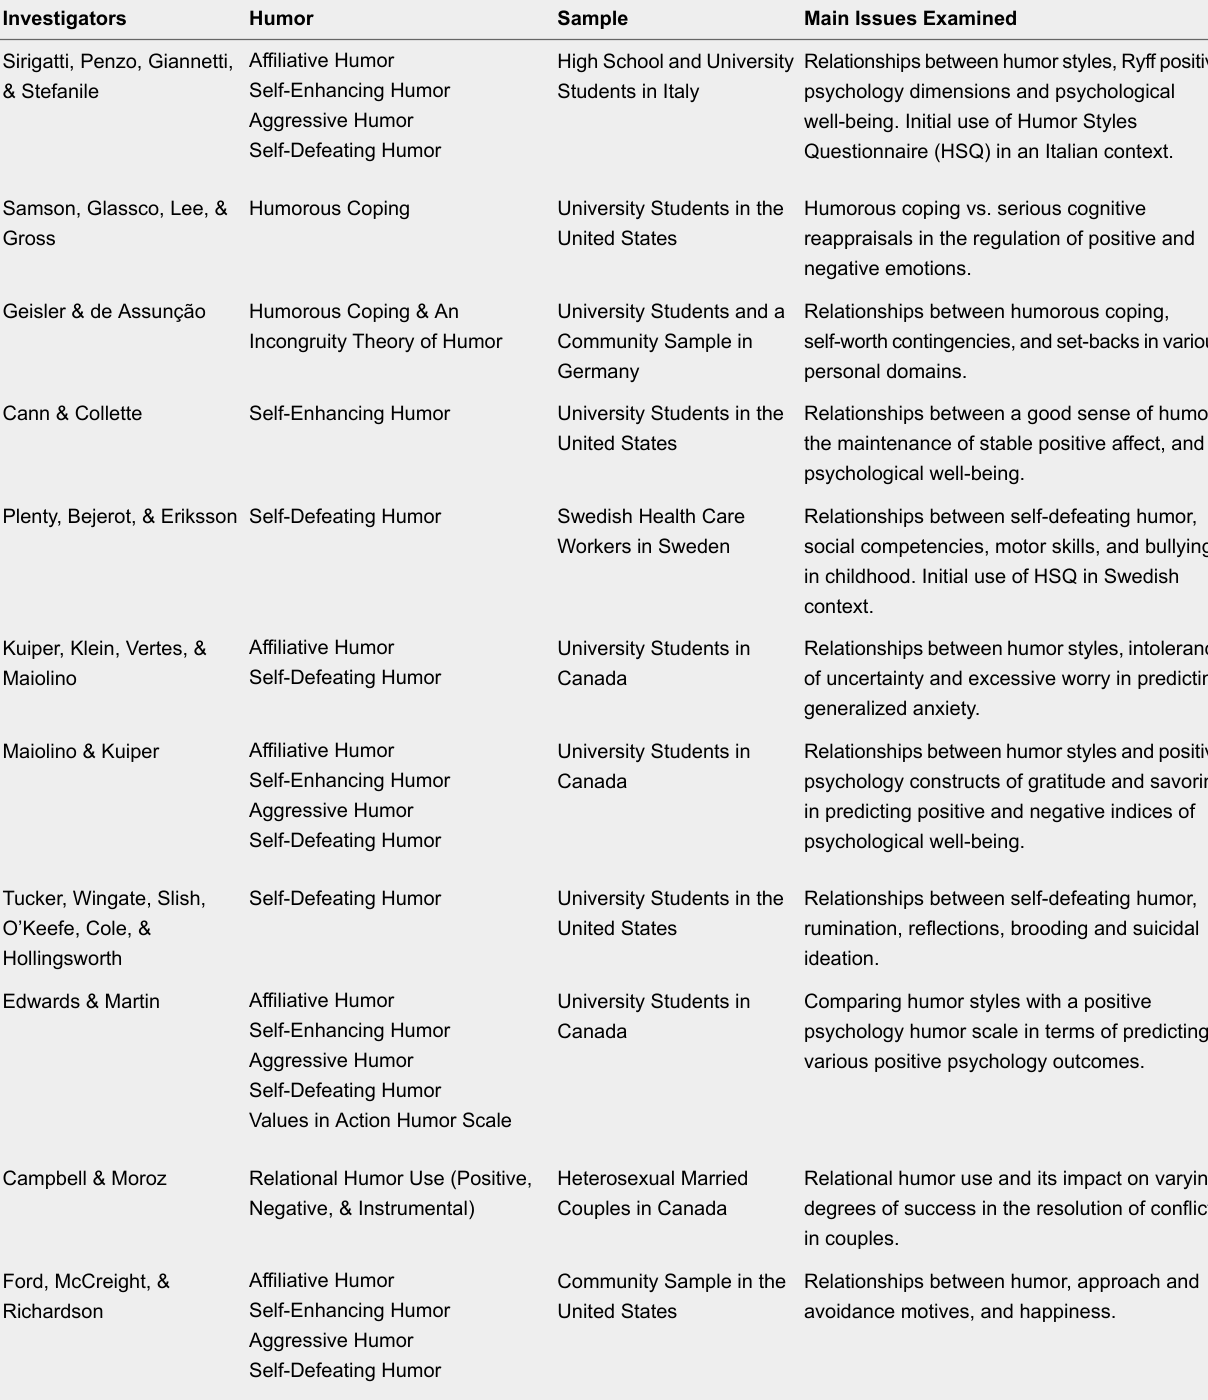
Overview of Research Studies in the Special Humor Issue of EJOP (August